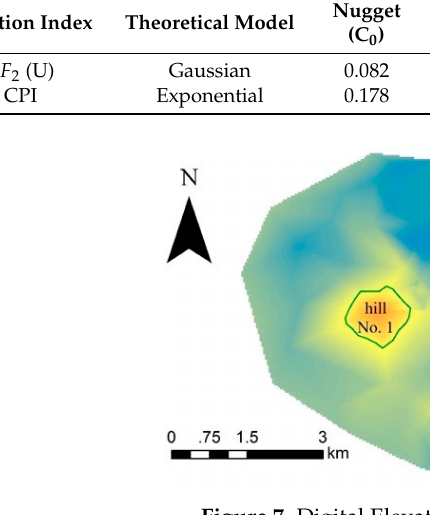
Figure 7. Digital Elevation Model of the study